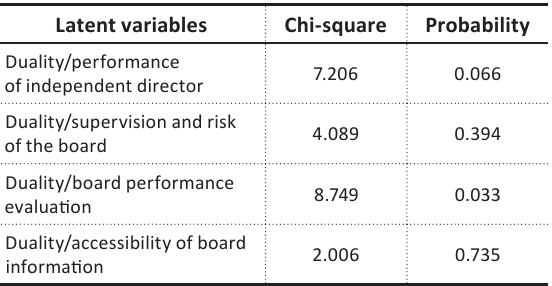
Table 8. Associativity test between the study